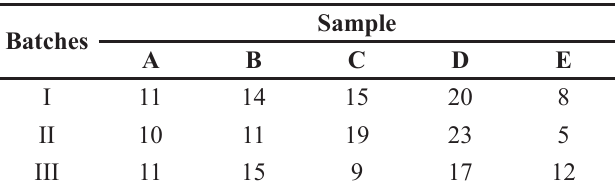
TABLE V - Number of months remaining until expiration date at the time of analysis Batches